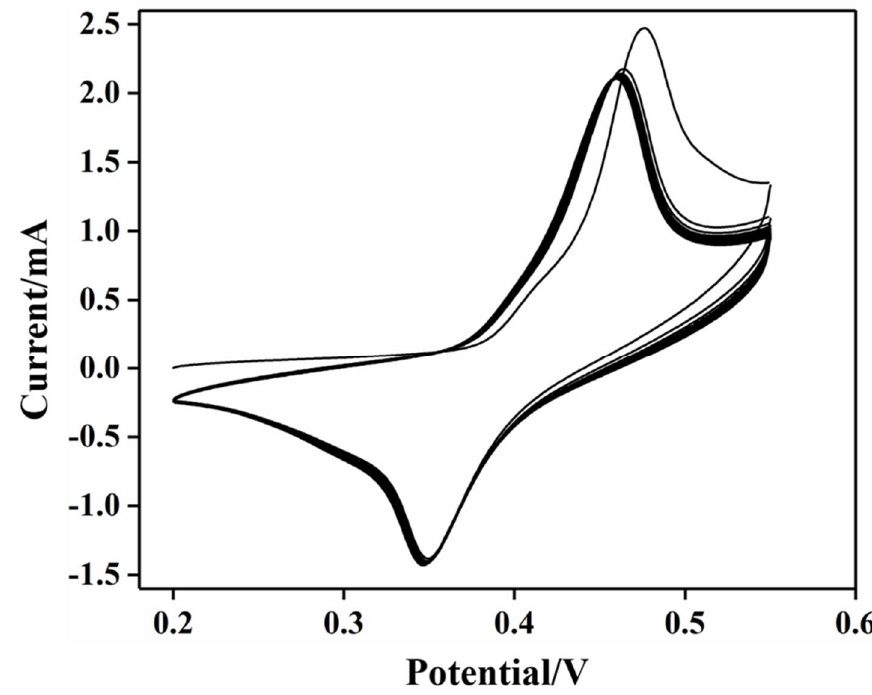
Figure 4. CV curves of Ni − DLC/TNT composite electrode solution were scanned continuously for 25 cycles at a scanning rate of 50 mV s − 1 (0.5 mol/L sodium hydroxide solution as a medium).